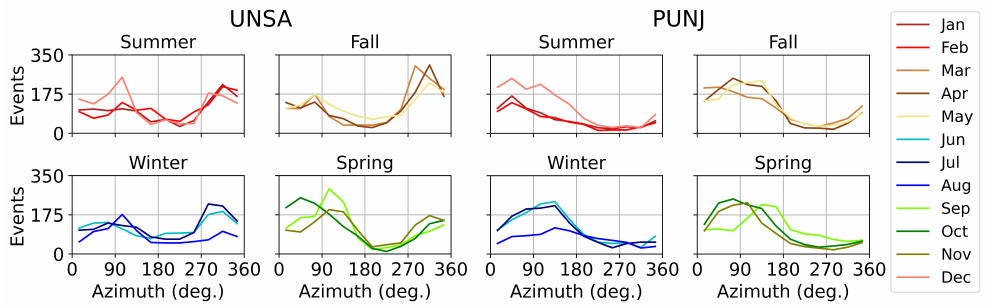
Figure 12. Azimuthal distribution of monthly-based wet gradients for the UNSA and PUNJ stations. Seasons are given as austral seasons (i.e., Summer is DJF), and the angular bins are defined as in Figure 11. The events indicate the number of hourly-sampled wet gradients that occur for each angular bin during each